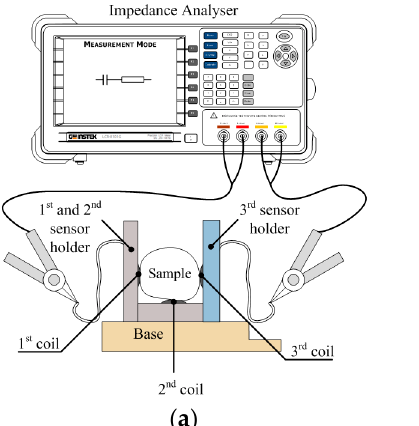
Figure 3. ( a ) Experiment setup for triple flat-type air coil sensor and its ( b ) equivalent circuit. Table 2. Experiment setup parameters.